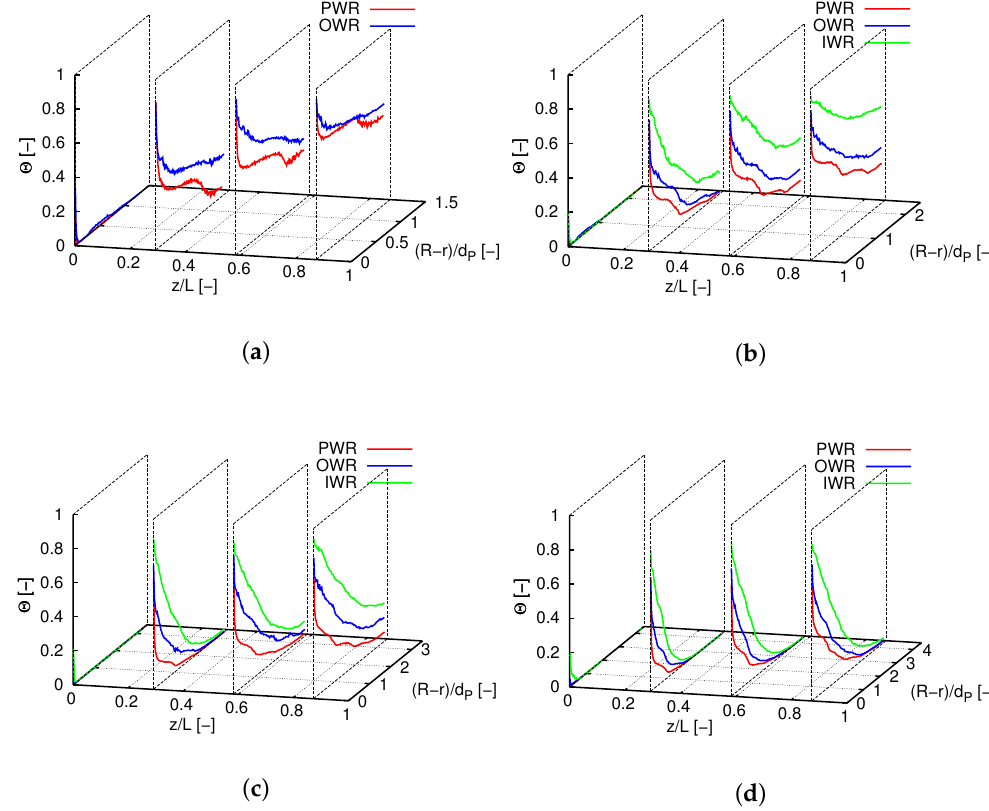
Figure 15. Radial temperature profiles for Re = 1600. ( a ) D / d P = 2.8, ( b ) D / d P = 4.8, ( c ) D / d P = 6.8, ( d ) D / d P =